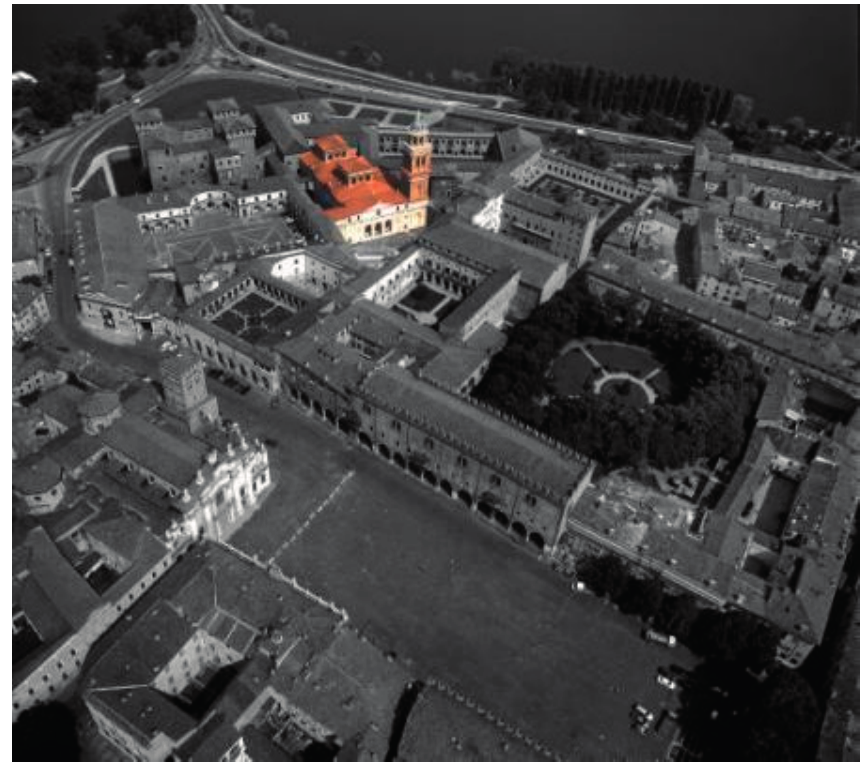
Figure 1. Santa Barbara Church and its bell tower in the historical urban